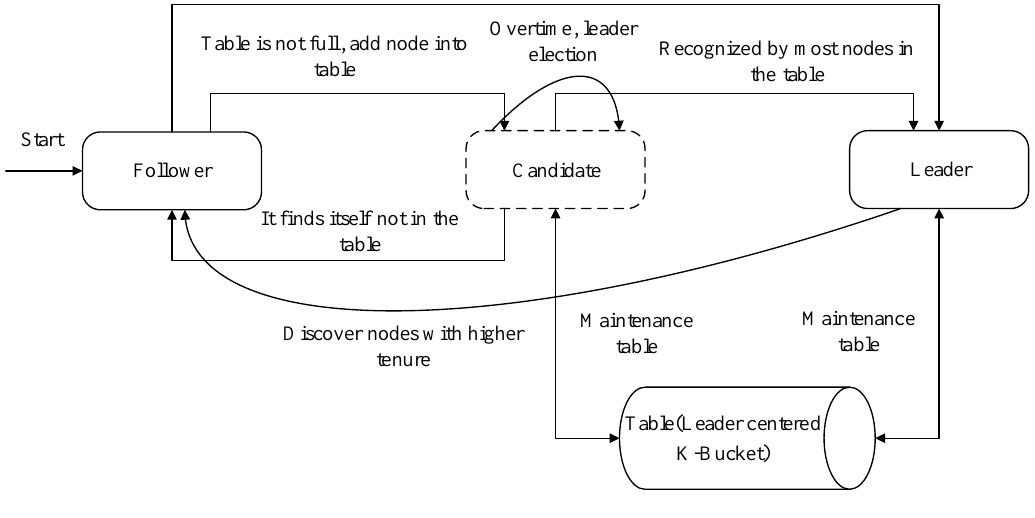
Figure 5. Leader election process.